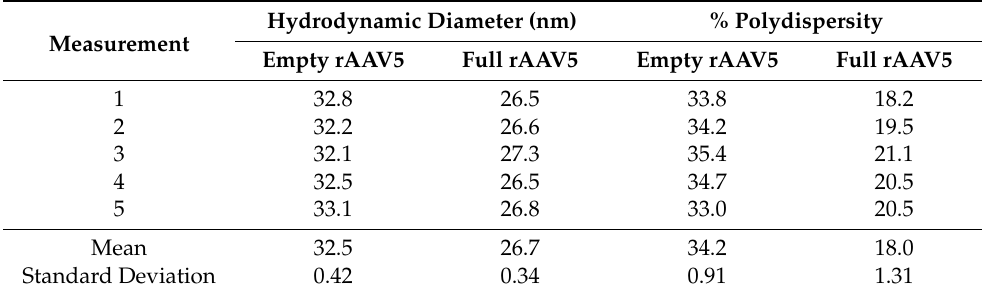
Figure 9. Intensity particle size distributions obtained for empty and full rAAV samples using MADLS. Table 6. Summary of the DLS results for neat concentrations of empty and full rAAV samples measured using backscatter detection.